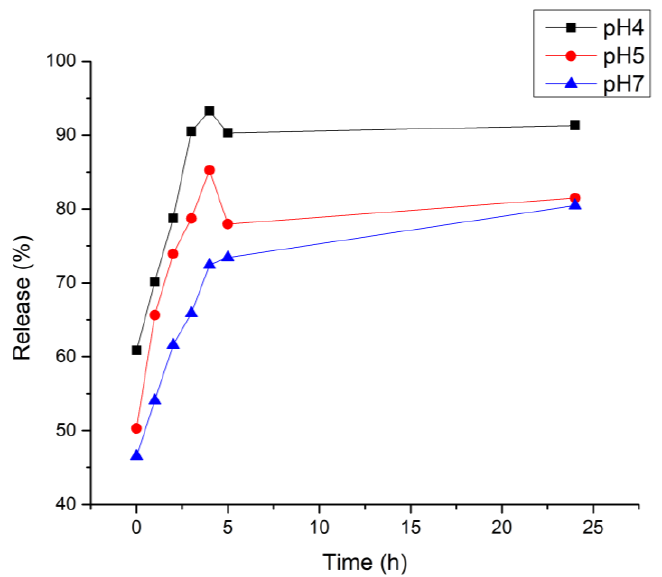
Figure 5. Comparison of the caffeine release profiles from MSNs-Caf-PbAE at different pH values.